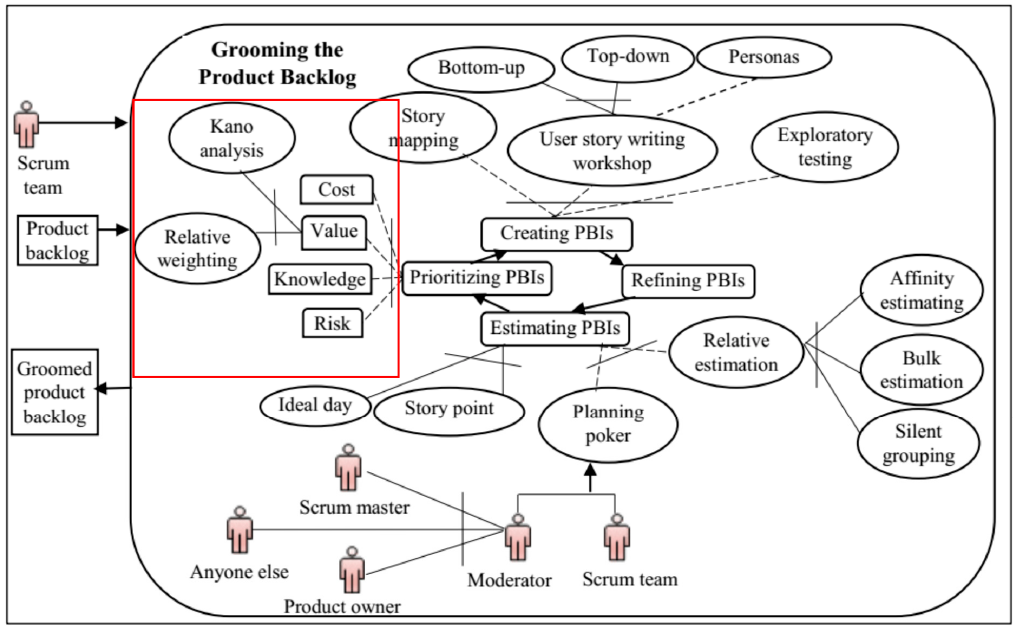
Figure A3. Variabilities identified in “Grooming the product backlog”.